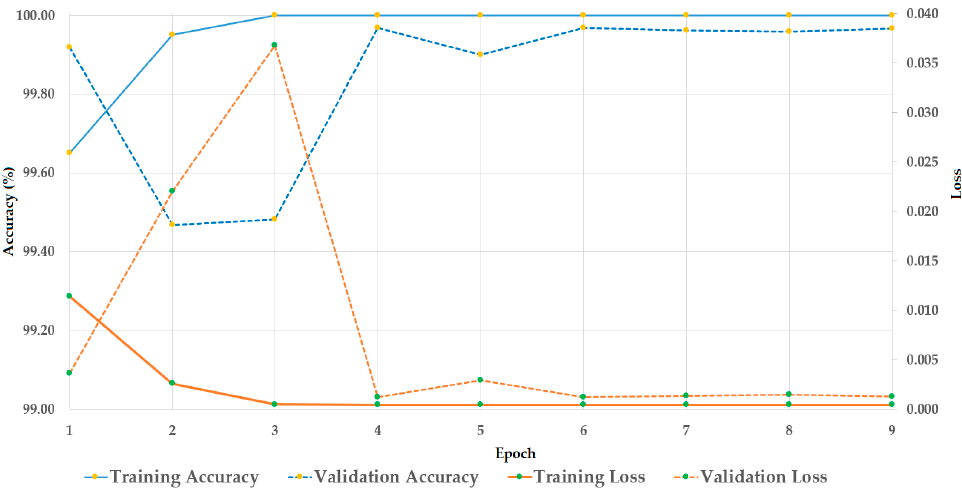
Figure 10. Convergence graphs (accuracy and loss) of the training procedure on the Replay-mobile dataset.